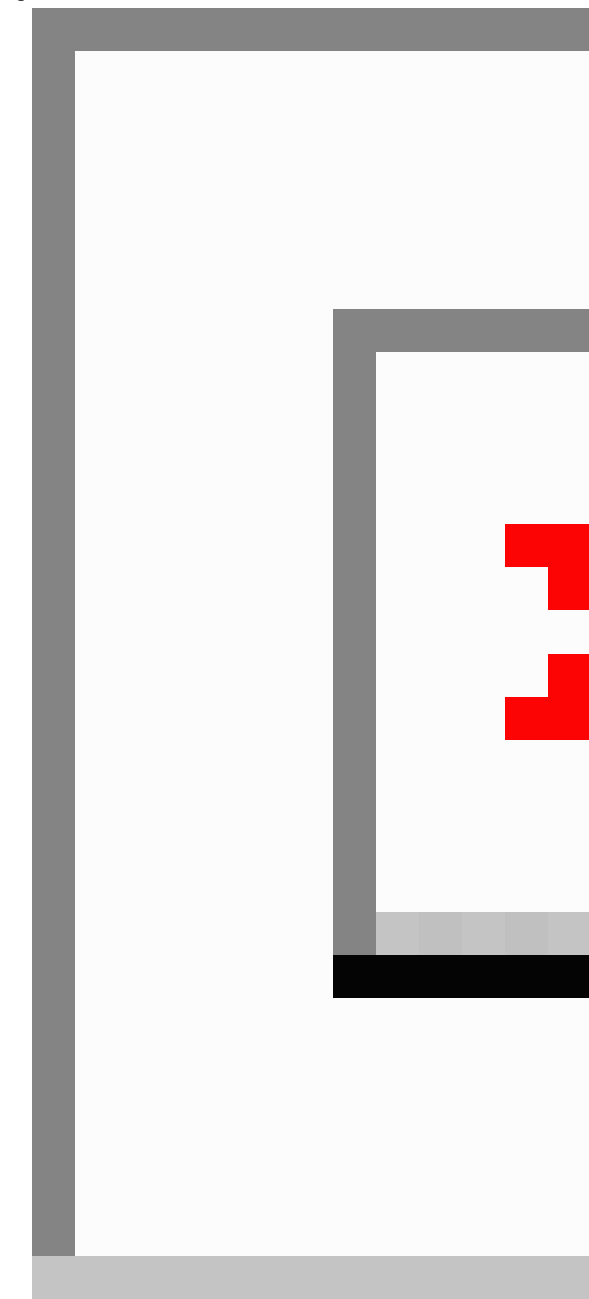
Figure 3. Enrollment flowchart for Phase